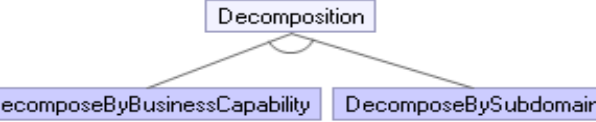
Figure 9. Feature diagram of provisioning and configuration management. Within the scope of provisioning, operations such as introducing the information technology (IT) infrastructure and then managing the resources needed by this infrastruc- ture are handled. In addition, providing this infrastructure to the service of the system and users is also one of the provisioning activities. There are four subtypes: service, user, server, and network, coming after provisioning. It is a process to maintain systems and software, which ensures that systems remain in the desired state. With any configuration management tool, we can separate and manage the system into related groups or modify the basic configuration center, prioritize some actions, and automate processes, such as updating the system and expanding new settings [35]. Infrastructure as code can be con- sidered as the next step. With this feature, one can program infrastructure by writing code and configure it the way it is wanted. In other words, one writes code to automate the infrastructure and run it. The idea behind this approach is that the systems and devices used to run the software themselves can be treated like software [36]. 4.8. Security In an MSA, security is actually gathered under two main headings as in all other systems, as shown in Figure 10. These are authorization and authentication. As shown in Figure 10, both are concepts to be addressed. However, handling these processes in MSA can create a more complex structure compared to the monolithic architecture. There are some best practices and patterns for this. Figure 10. Feature diagram of security. For authentication, a token is usually given to the user by performing an identity check through a structure that is developed into a communication task between the exter- nal world and the internal world, such as the API Gateway. This token contains the infor- mation that the user has authenticated to the system and what his/her permissions are. Thanks to this structure, the user can authenticate from a single point to a structure with many services. This eliminates the disadvantage that many services have relations with the outside world. Moreover, in this way, the services inside will have the convenience of talking to each other with HTTP instead of HTTPS as an example. In this case, however, it should not be forgotten that the API Gateway is a centralized failure point and the design